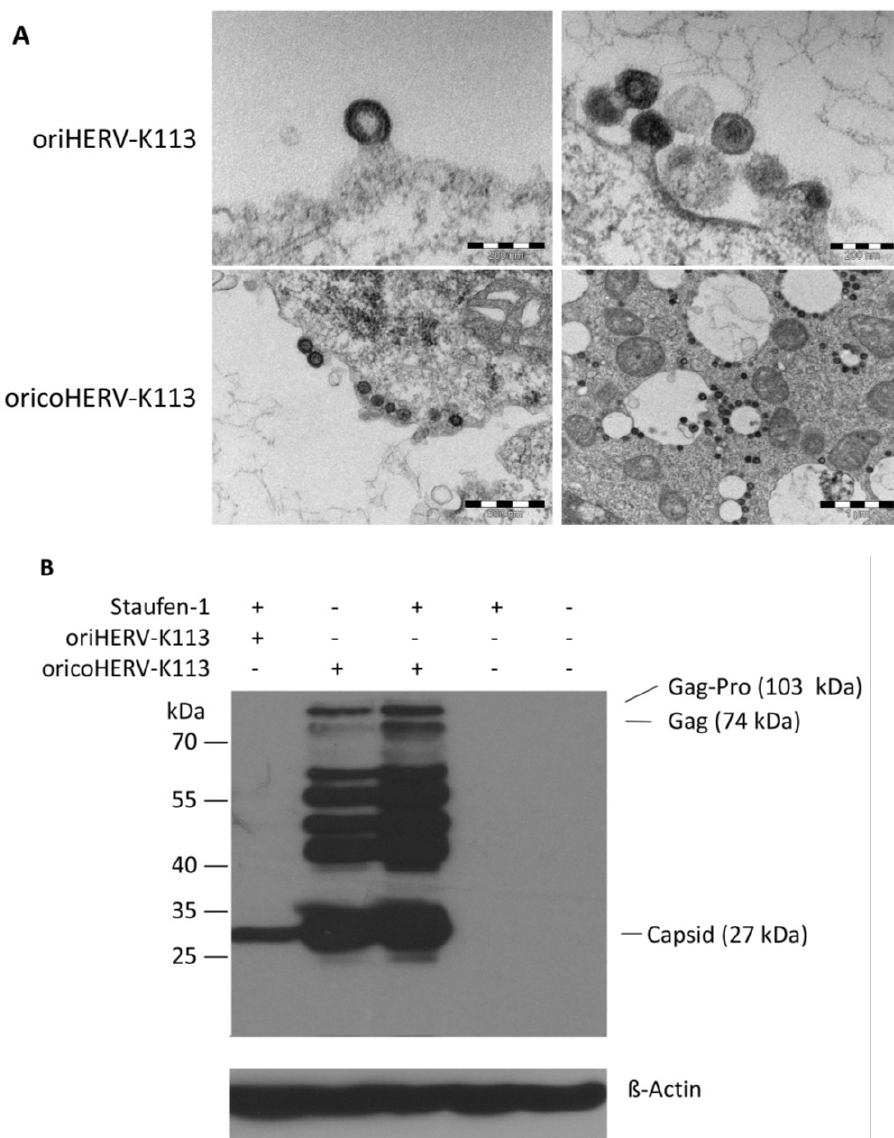
Figure 5. Thin-section EM of oriHERV-K113 and oricoHERV-K113 particle production after co-transfection of full-length molecular clones with Staufen-1 in a 4:1 ratio to enhance protein production. ( A ) Upper panel: EM of particles produced by oriHERV-K113 after co-transfection with Staufen-1. No changes in C-type morphology can be seen despite enhancement of protein production by Staufen-1. Lower panel: Same experiment with oricoHERV-K113, no influence on the A-type morphology can be seen as a result of moderate Staufen-1 enhancement. ( B ) Western blot of Staufen-1-mediated enhanced Gag protein expression in HEK 293T cell lysate. Cells were transfected with oriHERV-K113 and Staufen-1 (4:1 ratio), oricoHERV-K113, oricoHERV-K113 and Staufen-1 (4:1 ratio), Staufen-1 alone and with empty vector as mock control (left to right). Intracellular Gag was detected by Gag (CA)-protein specific antiserum. As loading control, the membrane was stripped and re-probed with a ß-Actin specific monoclonal